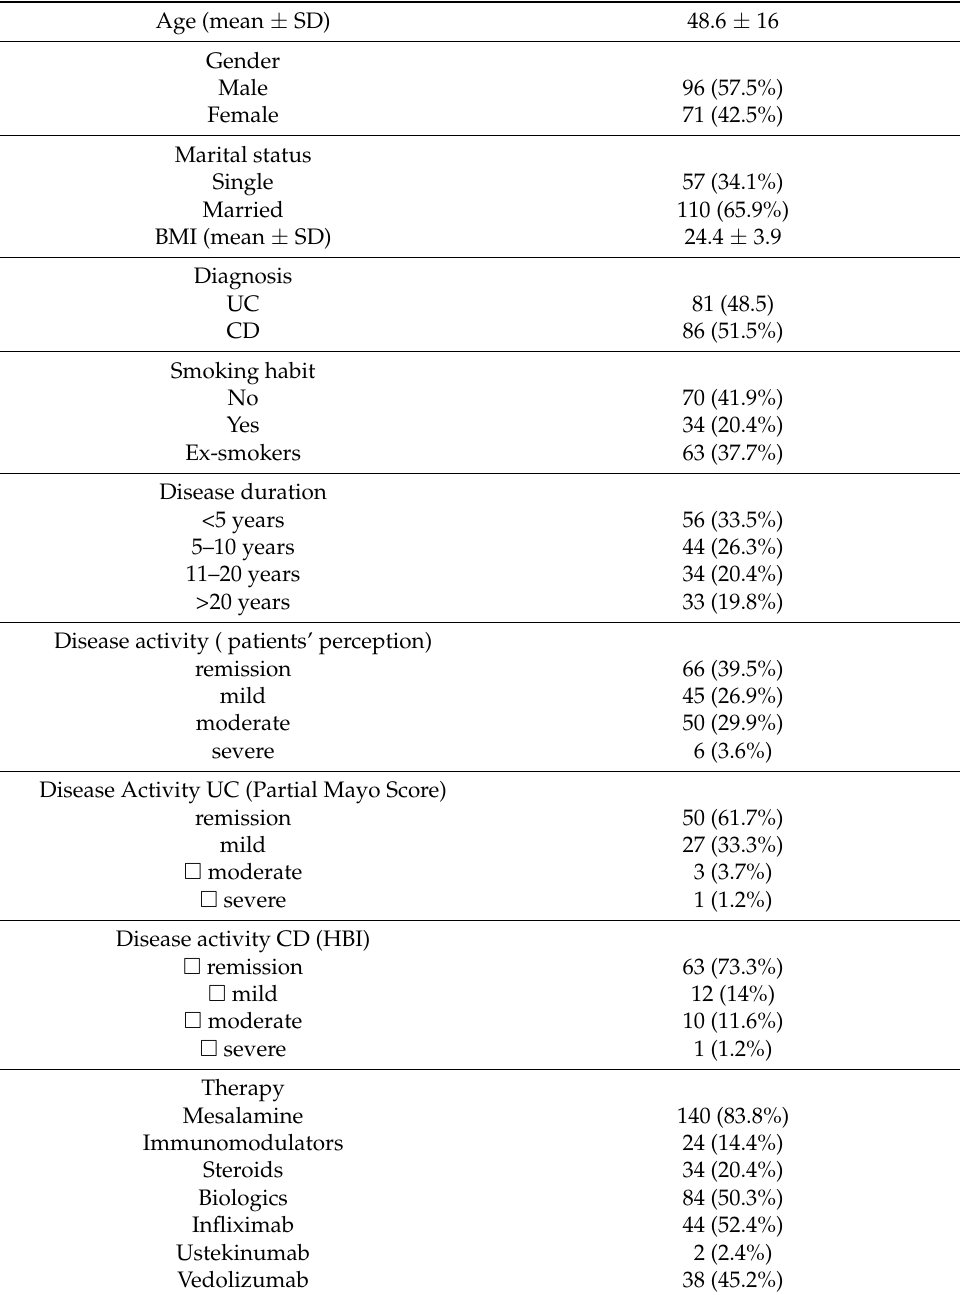
Table 1. Baseline characteristics of the whole study